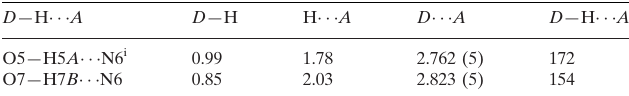
Hydrogen-bond geometry (A˚ , (cid:4)